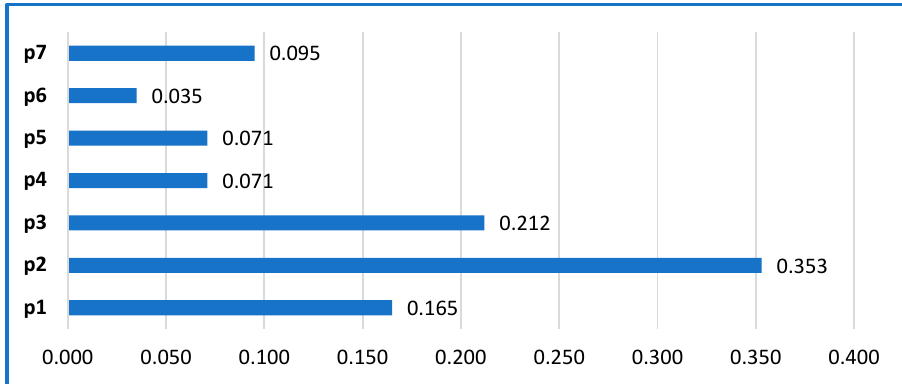
Figure 5. Graphical visualization of analytical assessments for the states of Model “A”.